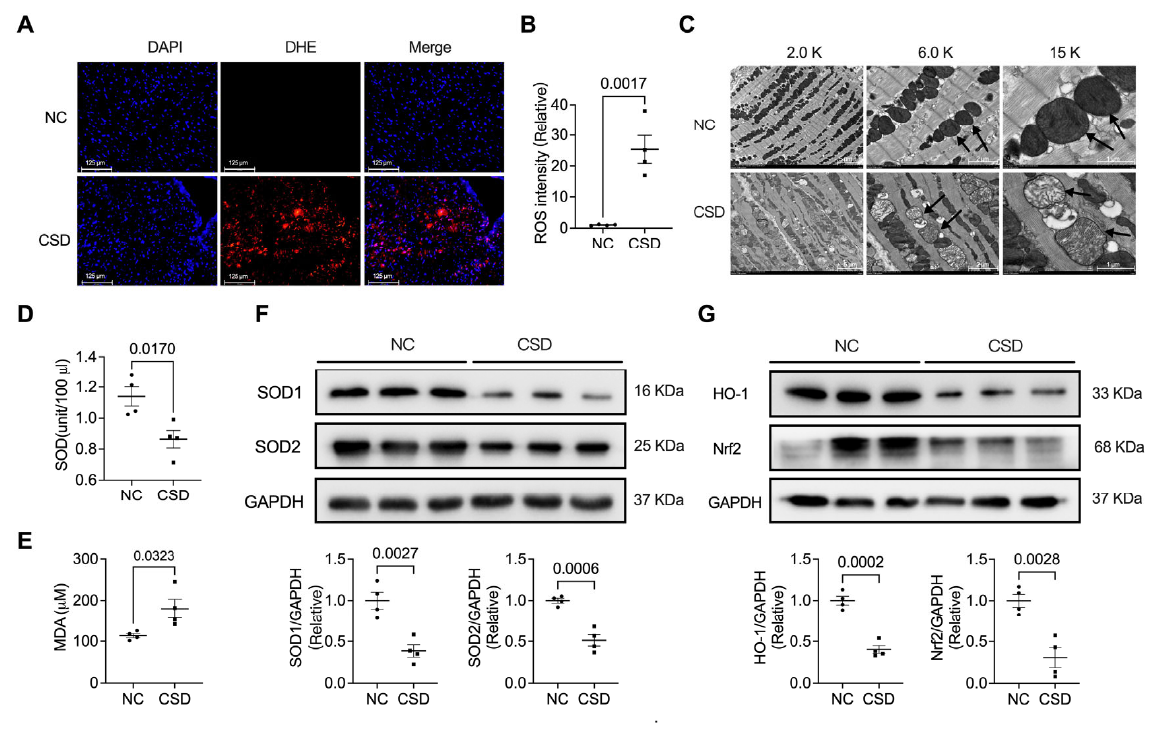
Figure 2. CSD induced mitochondrial impairment and elevated oxidative stress in the heart. ( A ) DHE staining and analysis ( B ) unravels increased lipid peroxidation in the CSD heart, indicating elevated oxidative stress. DHE fluorescent intensity was measured by ImageJ (scale bar = 125 µ m). ( C ) Electron micrographs showing mitochondria in heart tissue obtained from control (NC) and chronic sleep deprivation (CSD) mice (scale bar = 5 µ m, 2 µ m, 1 µ m). Serum levels of SOD ( D ) and MDA ( E ) in NC and CSD mice. ( F ) Representative Western blot image and quantification of SOD1 and SOD2 in NC and CSD hearts. ( G ) Representative Western blot image and quantification of HO-1 and Nrf2 in NC and CSD hearts.